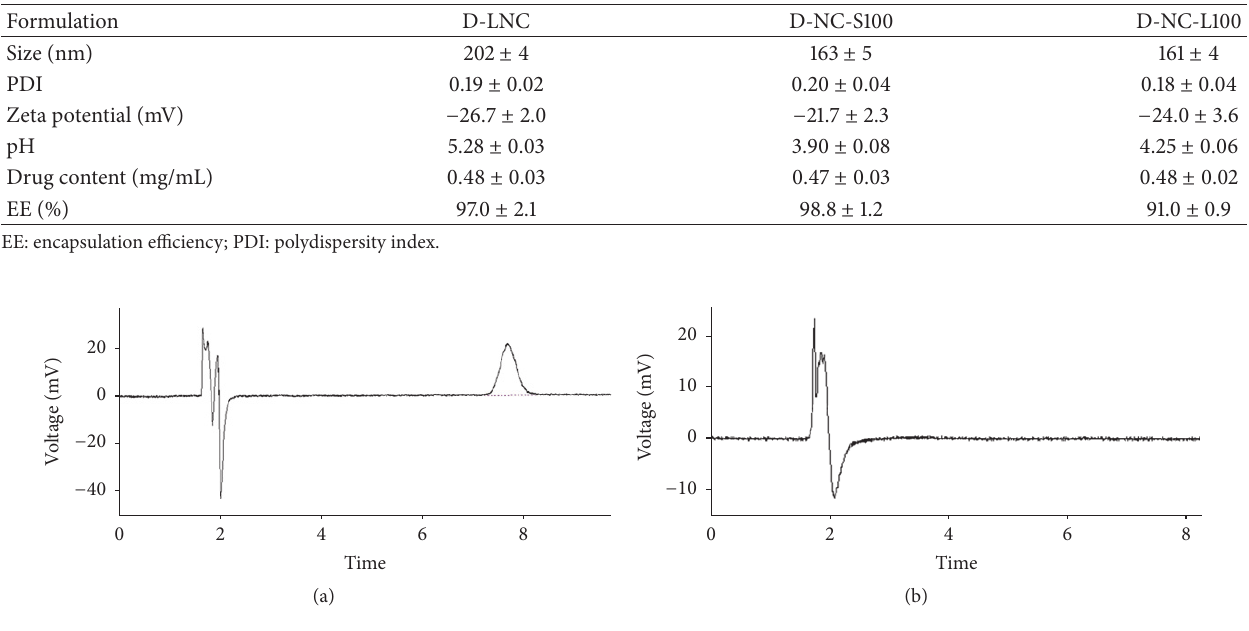
Figure 1: HPLC chromatogram (a) for standard desonide and (b) for LNC.